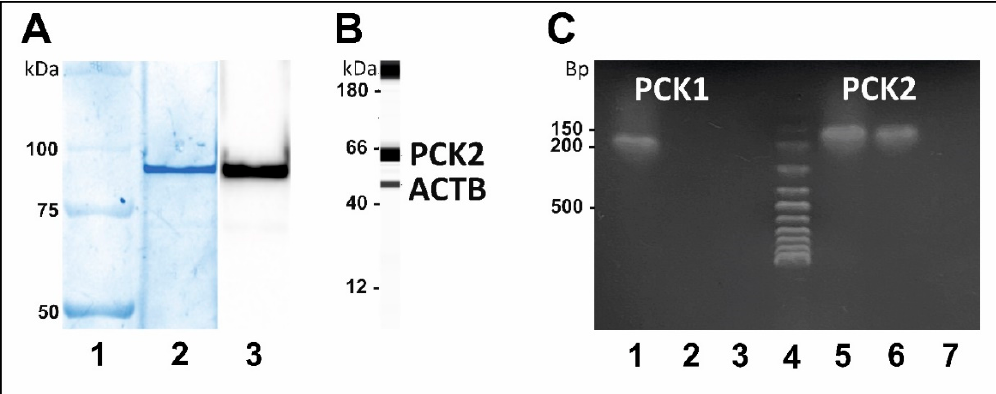
Figure 6. Identification of PCK-2 in dissected Langerhans. ( A ) Western blot analysis of recombinant PCK2: Lane-1: Marker; Lane-2: 1µg of recombinant PCK2 were examined onto 10% SDS-PAGE; Lane-3: Western blot analysis of recombinant PCK2 using anti-PCK2 antibodies (1:1000). We observed the immunogenic band of PCK2 at 96 kDa. ( B ) Capillary western blot of dissected Langerhans islets from rat pancreas using anti-PCK2 Abs (1:75). We observed the immunogenic band of PCK2 at 63 kDa. ( C ) Agarose gel electrophoresis of qPCR products of PCK1 and PCK2 amplified: Lane-1: kidney (+ve control); Lane-2: dissected Langerhans islets from rat pancreas; Lane-3: Water (-ve control); Lane-4: Marker; Lane-5: kidney (+ve control); Lane-6: dissected Langerhans islets from rat pancreas; Lane-7: Water ( − ve control).